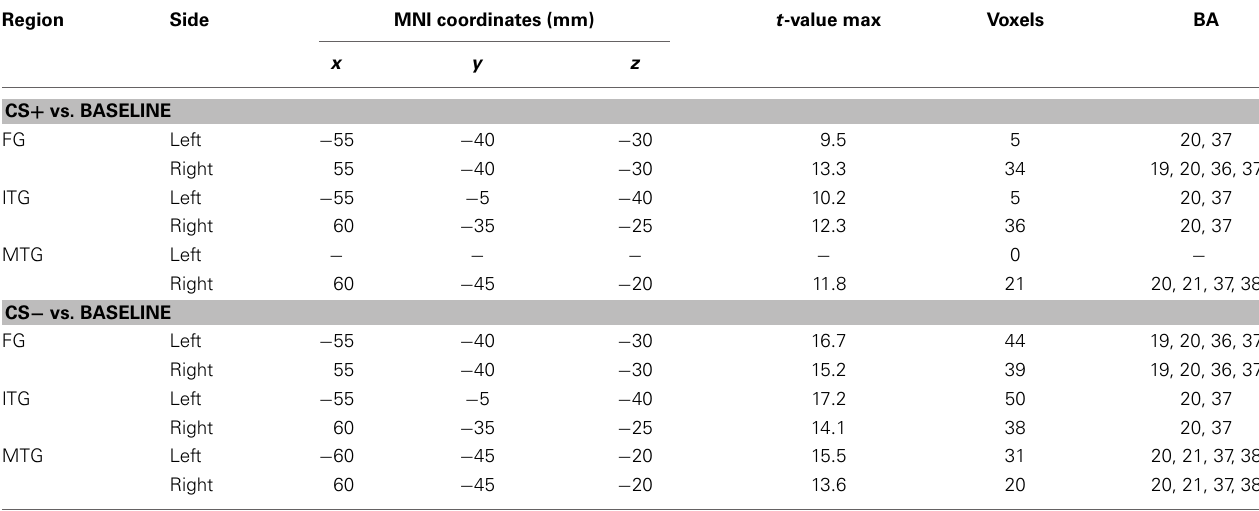
Table 1 | Brain areas of significant activity ( p < 0 . 05) under the face image types in relation to the baseline. Region